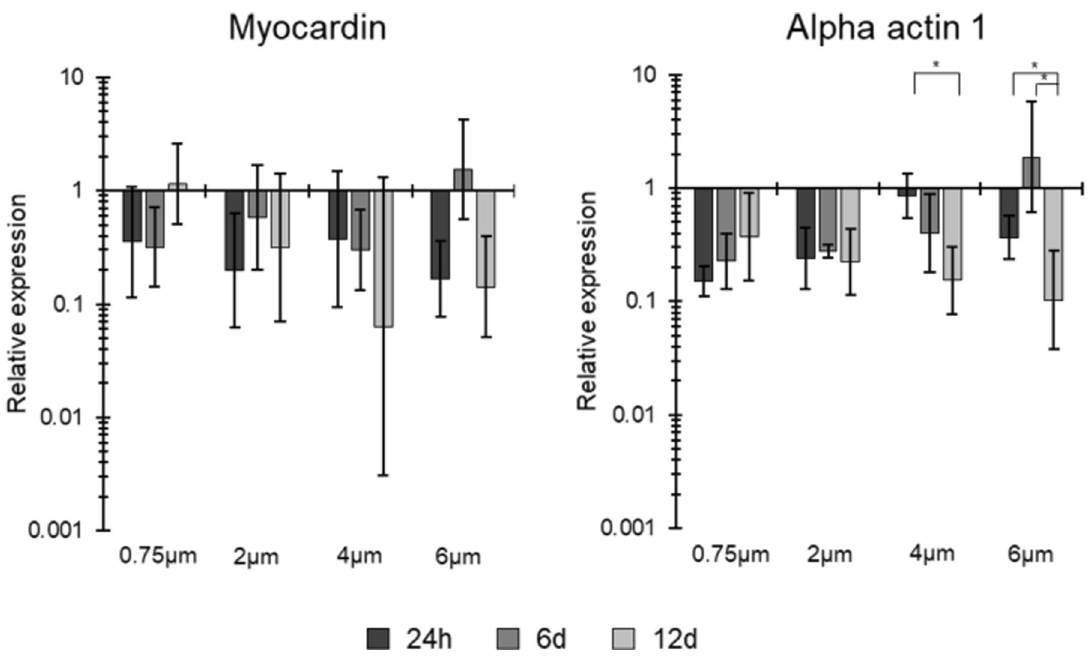
Fig. 6 RT-qPCR results for myocardin and alpha actin 1 on all four scaffolds after 1, 6 and 12 days of culture. All results were normalised to 70% con fl uent HUVSMCs on tissue culture plastic. n ≥ 3, error bars = SD. * p <